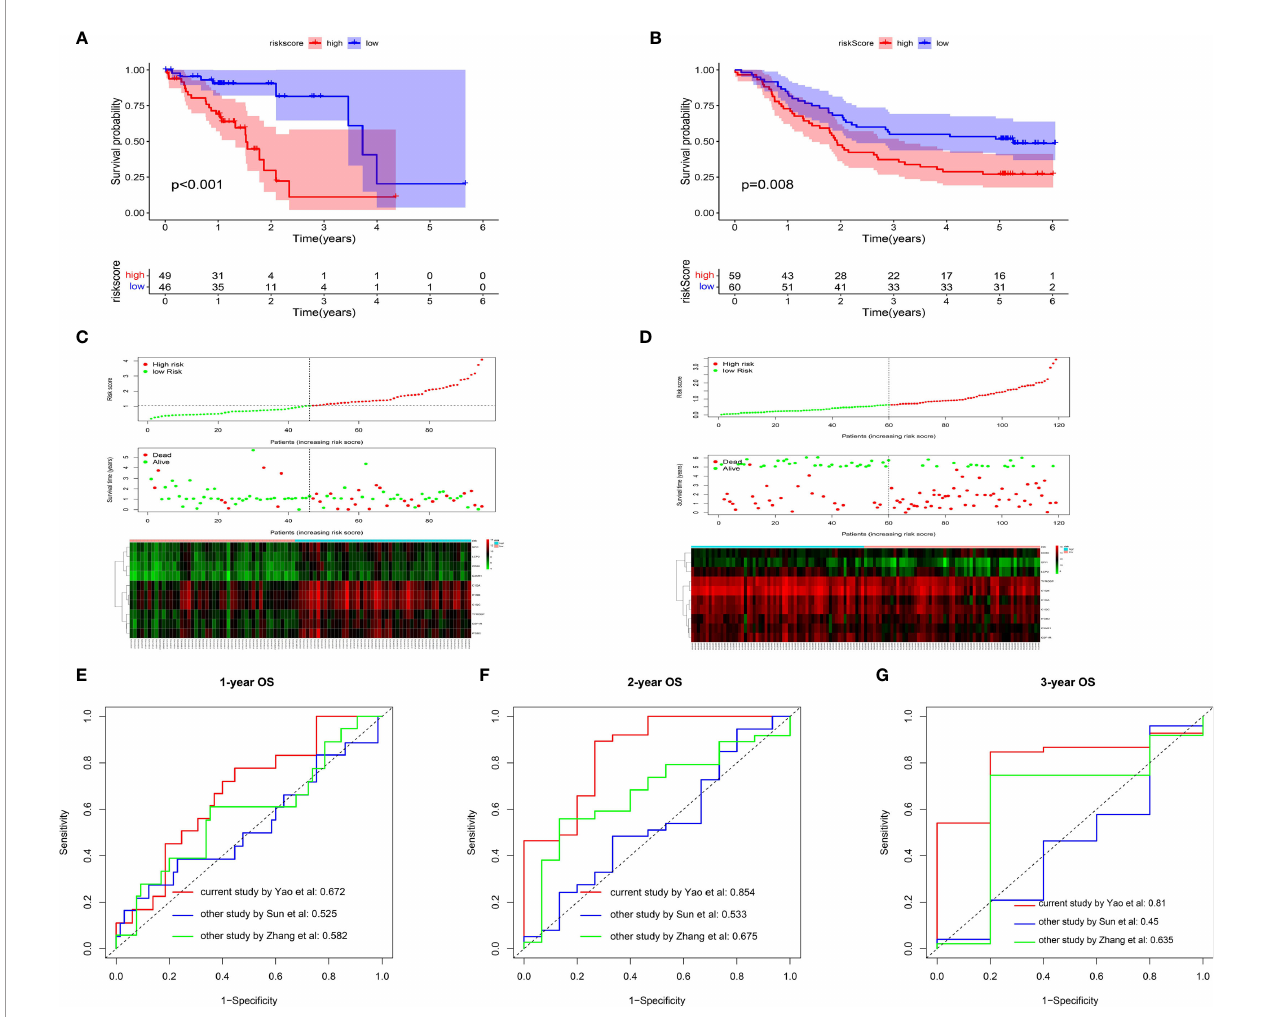
FIGURE 6 | Prognostic analysis of the risk score model. (A, B) Kaplan-Meier survival curve of risk score model among ESCC patients in TCGA cohort (A) and GEO cohort (B) .The high-risk group show the poorly prognosis (p<0.05). (C, D) Relationship between the risk score (upper) and the expression of ten prognostic genes (lower) in TCGA cohort (C) and GEO cohort (D) . (E, F) Time-dependent ROC analysis was performed to compare the three models in predicting 1-year (E) , 2-year (F) and 3-year (G) OS.